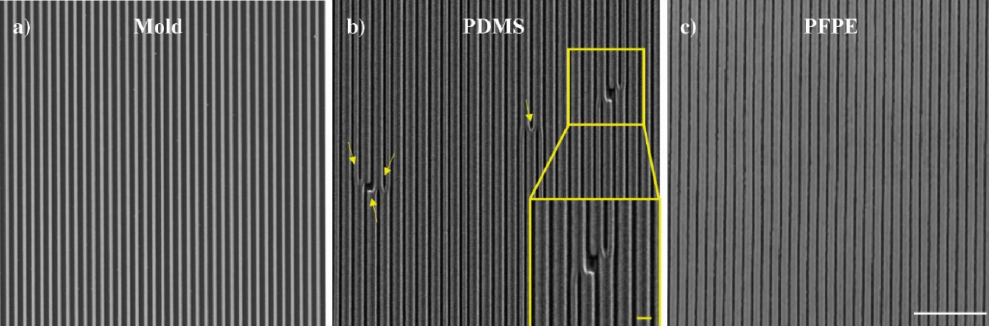
Figure 1. Scanning electron microscope representative images of ( a ) the 600 nm-periodic nano-grating initial mold, ( b ) the PDMS replica, and ( c ) the PFPE replica. Scale bar: 5 µ m. Yellow arrows highlight the presence of defects in the PDMS replica. Inset of ( b ) zoomed image of a representative area with defects, scale bar = 1 µ m.